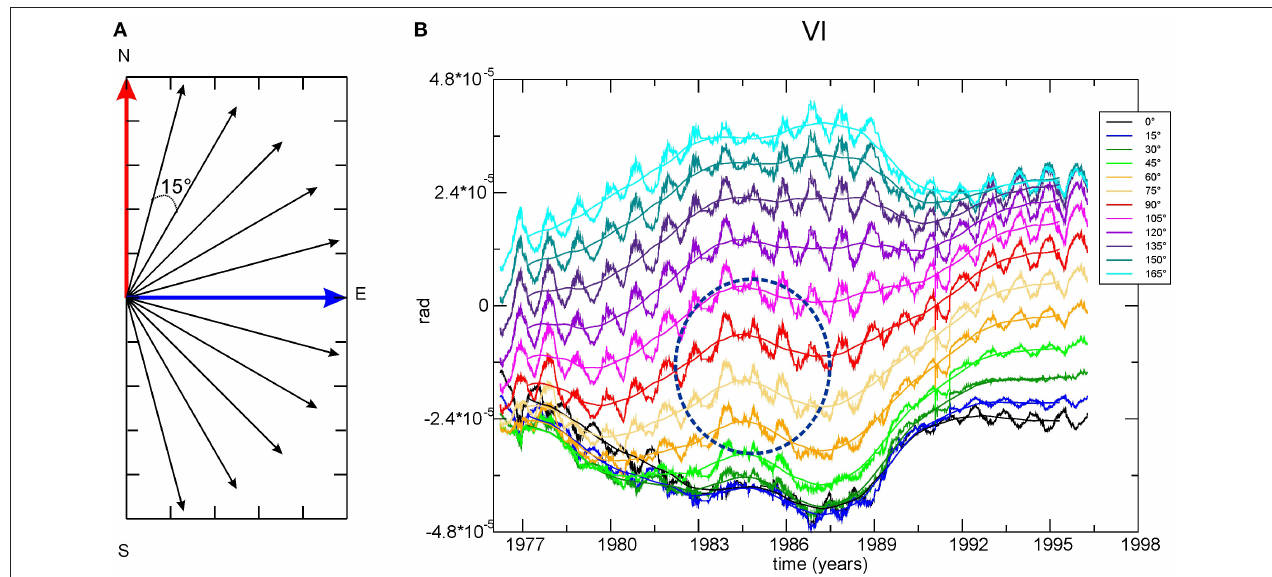
FIGURE 5 | (A) The tilt signal is calculated for directions separated by 15 ◦ intervals from N to S, starting from the N–S (red) and E–W (blue) records. (B) Example for VI: the time series calculated for various directions are plotted vs. time: in legend, the color corresponding to each direction. The maximum amplitude of oscillation 1983 and 1986 is recorded in N75 and N90 ◦ E directions (dashed blue ellipse). X-axis: time (years). Y-axis: signal amplitude (rad). Positive in the directions written in the legend.